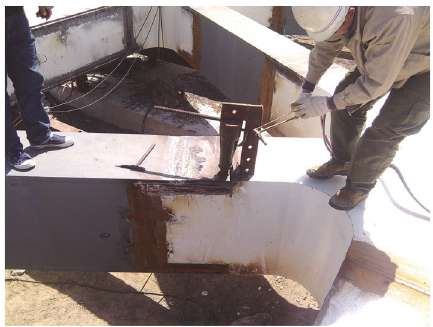
Figure 2: Gap due to installation